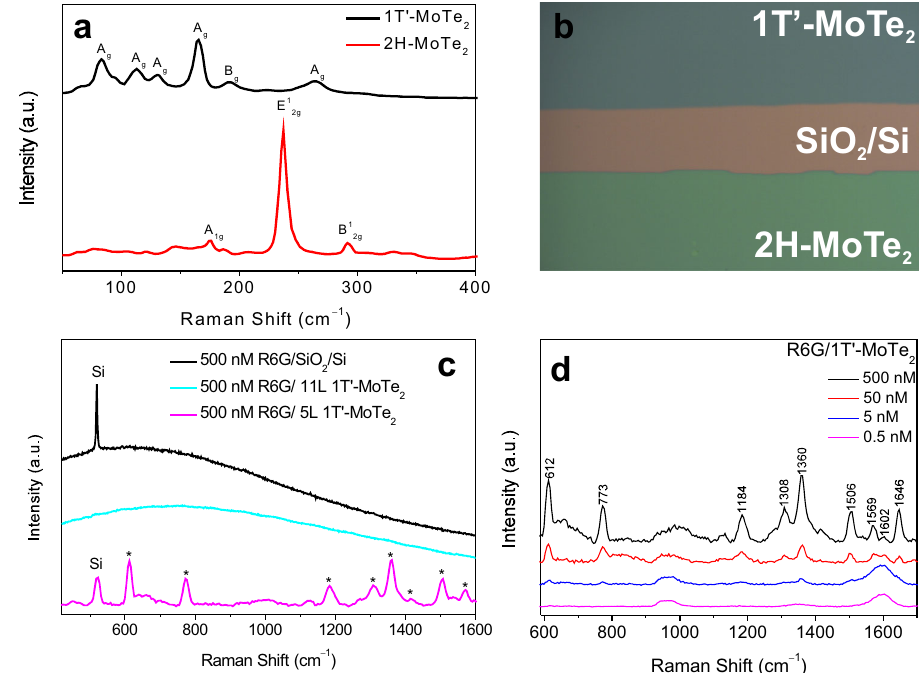
Fig. 5 One step growth of 1T ′ -MoTe 2 and 2H-MoTe 2 on a single substrate and SERS application of 1T ′ -MoTe 2 . In all, 532 nm Raman spectra from 1T ′ - and 2H-MoTe 2 grown simultaneously on 300 nm SiO 2 /Si substrate ( a ); an optical image of the two MoTe 2 phases grown simultaneously and separated by a ~20 μ m strip of bare SiO 2 /Si substrate for a better optical contrast ( b ); 532 nm Raman spectra of 500 nM solution of Rhodamine 6G drop casted on different substrates ( c ); concentration dependent 532 nm Raman studies of Rhodamine 6G spectra drop cast on the surface of 5 L 1T ′ -MoTe 2 fi lm on SiO 2 / Si substrate ( d